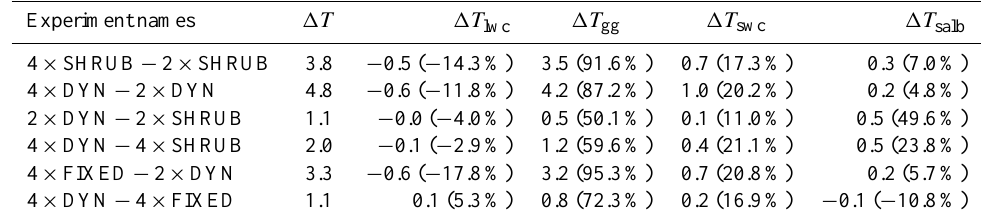
Table 4. Summary of the 1-D energy balance analysis. The total global MAT difference is denoted by 1T , 1T lwc is the component of 1T due to longwave cloud changes (i.e. changes in emissivity due to clouds), 1T gg is the component due to greenhouse gases, 1T swc is the shortwave cloud contribution (i.e. changes in albedo due to clouds) and 1T salb is the contribution of planetary surface albedo changes. The contribution from each factor as a percentage of 1T is shown in brackets. All temperatures are in degrees